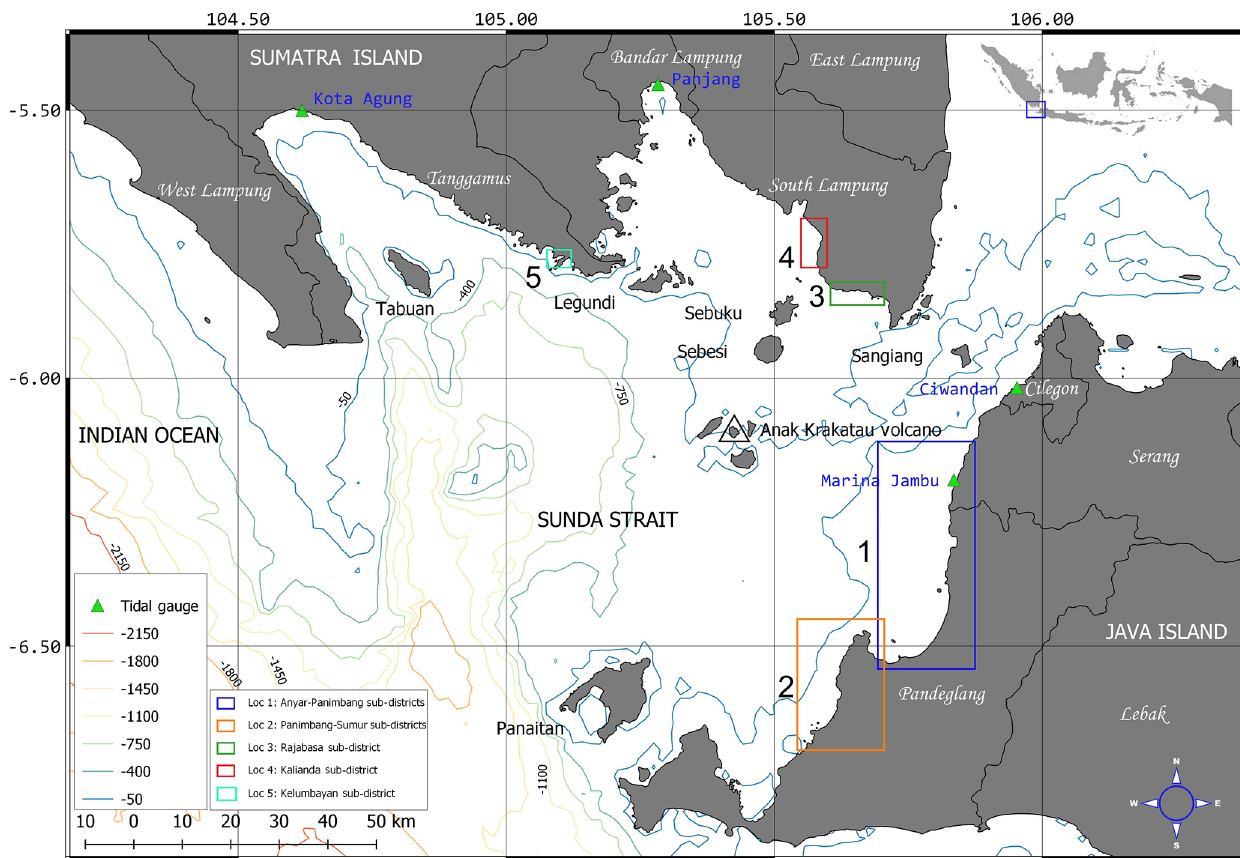
Figure 1. The surveyed area following the 22 December 2018 Mount Anak Krakatau volcanogenic tsunami. Five areas of the survey are marked by blue rectangles. Tide-gauge stations are marked by green triangles. Bathymetry data were adapted from Topex